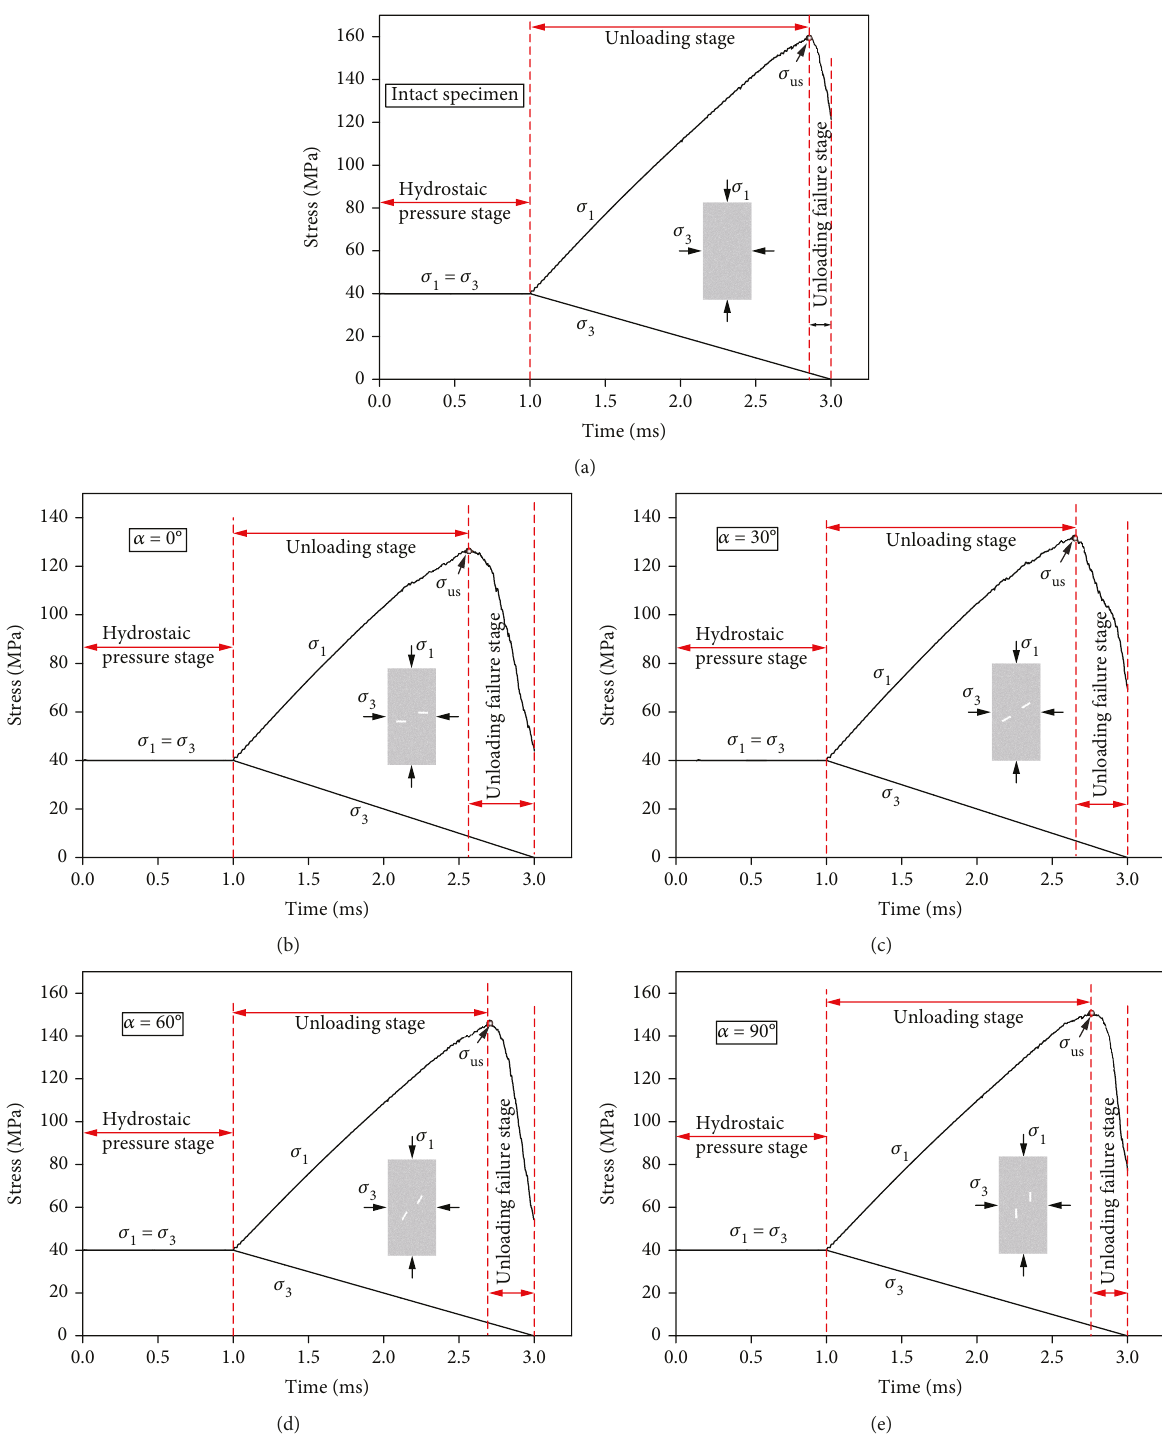
Figure 8: Stress – time curves of specimens under unloading